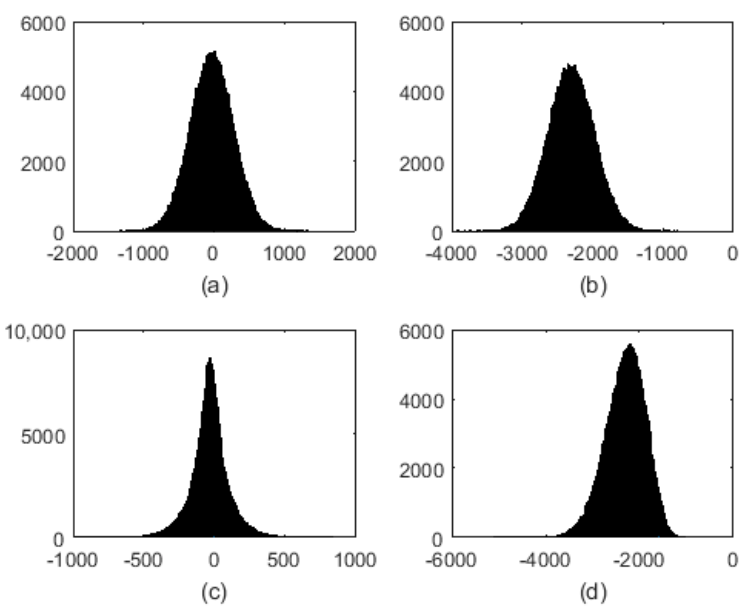
Figure 11. Histograms of the real ( a ) and imaginary ( b ) parts of the SAR image (before simulation); and histograms of the real ( c ) and imaginary ( d ) parts of the SAR image (after simulation).